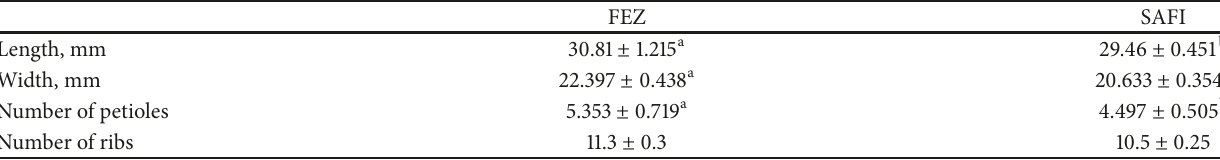
Table 1: Morphometric characterization of Capparis spinosa leaves collected from FEZ and SAFI.